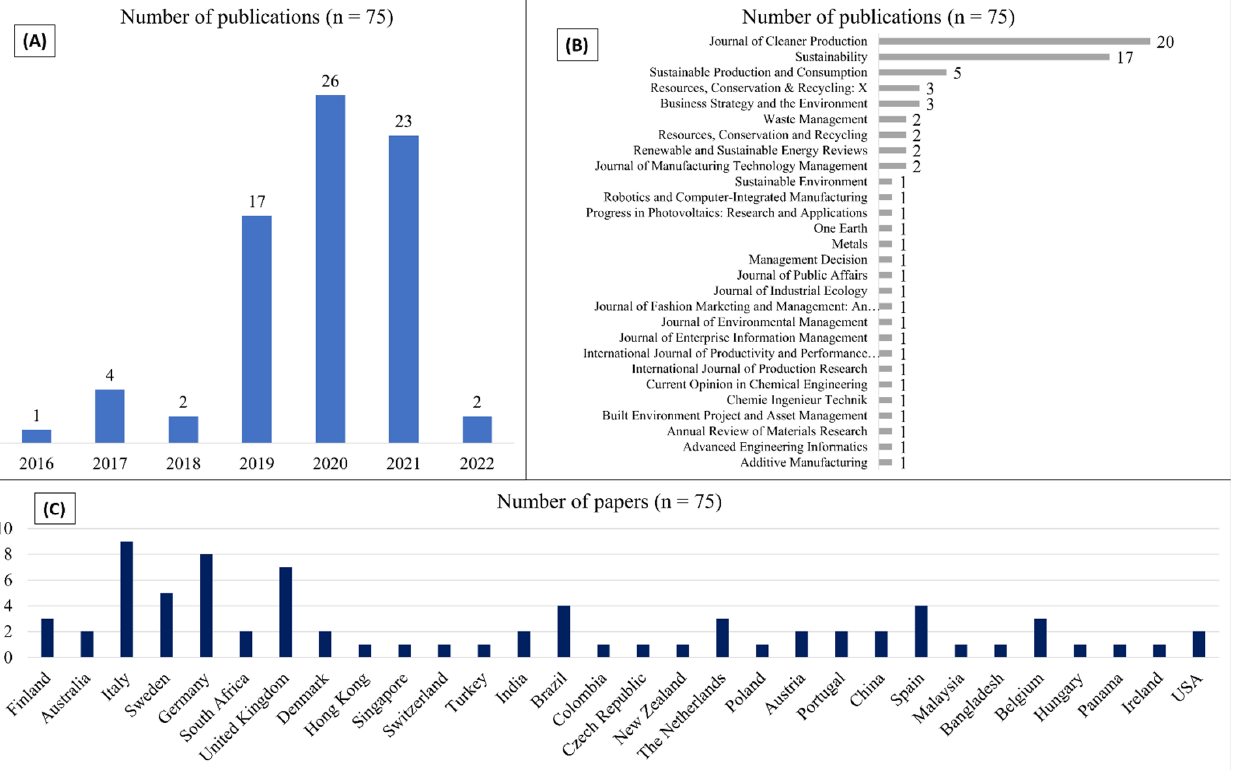
Figure 5. Descriptive statistics of the selected article: ( A ) year of publications; ( B ) journal outlets of the selected articles; and ( C ) country of publications.